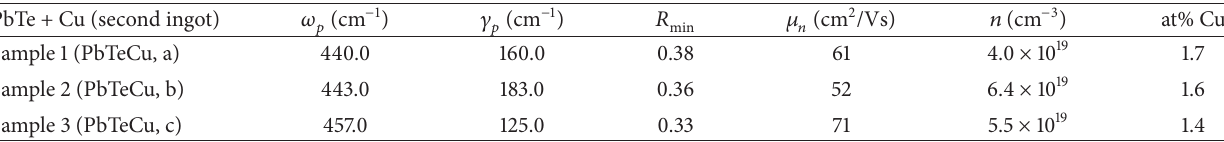
Table 3: Calculated parameters for PbTe doped with Cu (second